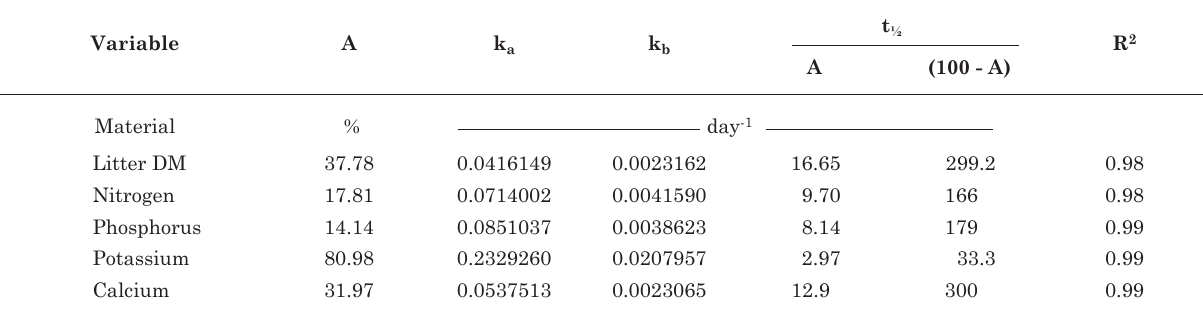
table 2. Parameters of double-exponential decomposition model fitted to the measured dry matter values, n, P, K, and ca remaining in the litter; decay constants ( ka and kb ); half-life (t 1/2 ) of each compartment and coefficient of determination (r 2 ) for the fitted